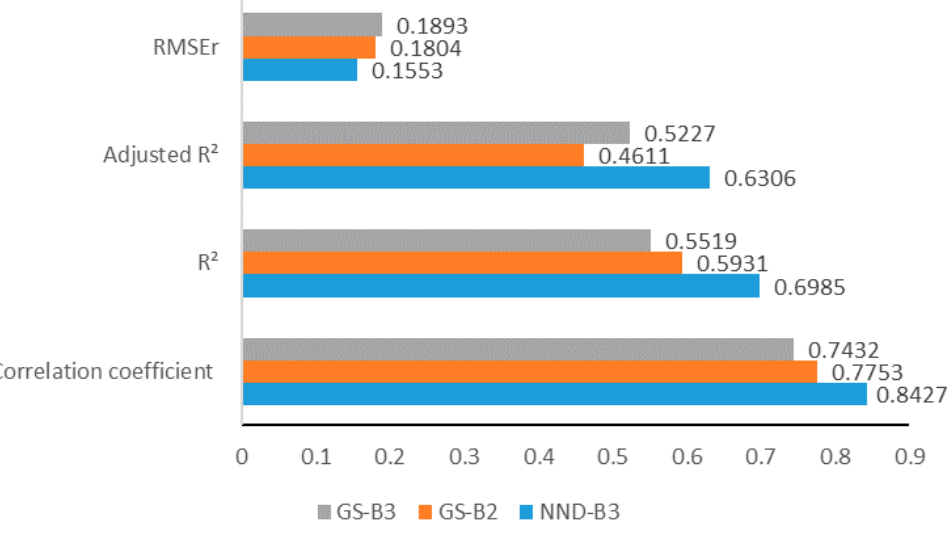
Figure 7. The estimation results of three images by the stacking